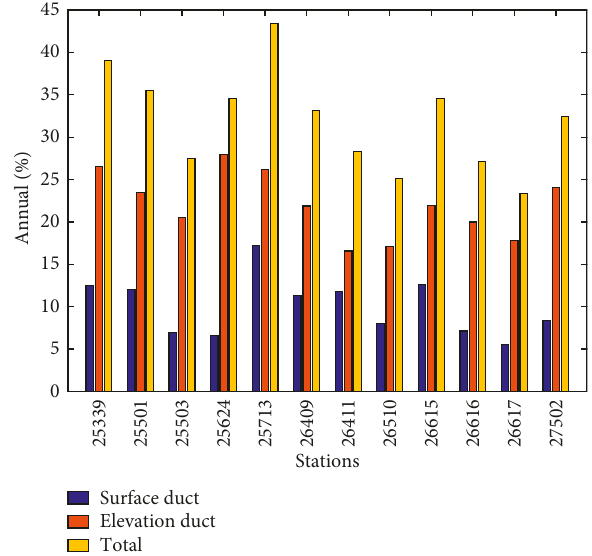
Figure 3: Annual average probability distribution (%) of surface, elevation, and total ducts at 12 stations in Table 1: Annual average probability of surface and elevation ducts.